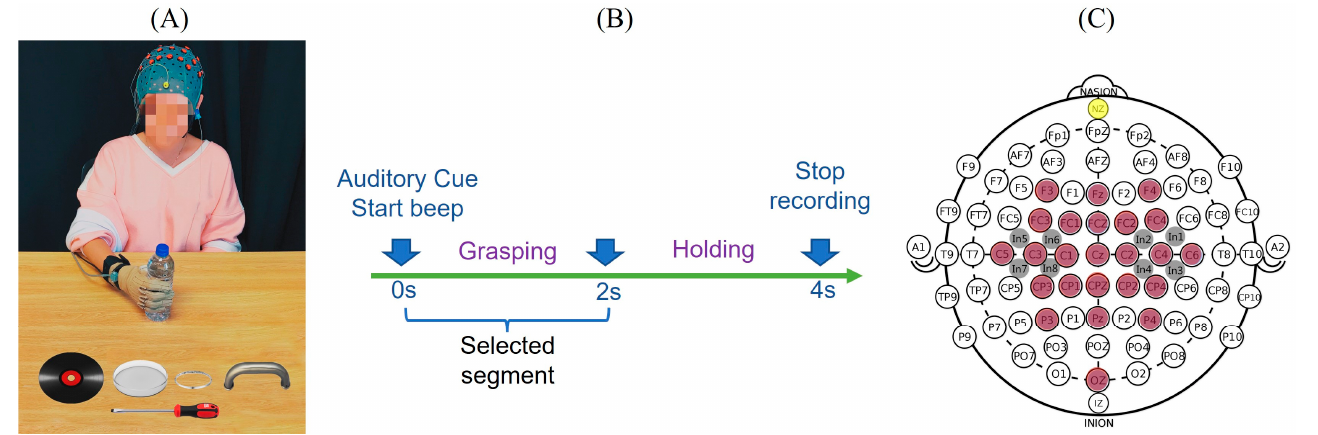
Figure 1. Experimental setup, electrode placement and the protocol. ( A ) The subject was asked to perform six types of hand movements by grasping six different objects including a water bottle, a CD, a petri dish, a screwdriver, a bracelet and a door handle. During the movement, both hand kinematics and EEG activities were recorded. ( B ) The start of hand movement was instructed by an auditory cue, and the subjects grasped and held the object until the ‘stop’ cue. ( C ) Neural signals were recorded using 32 electrodes including 24 denominative electrodes (in brown) and 8 intermediate locations (in grey). Adapted from [32,33].